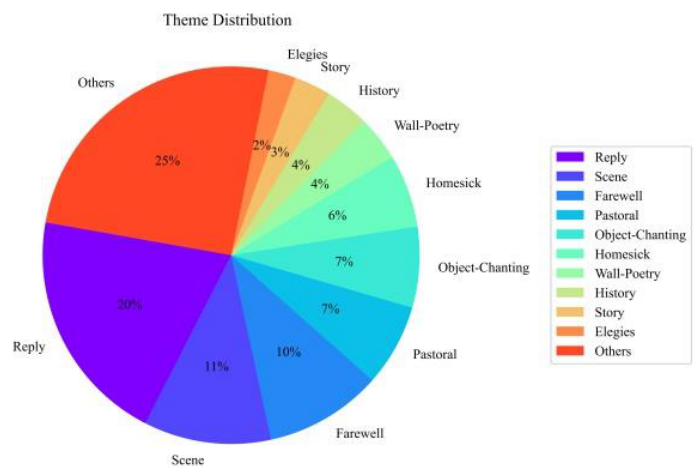
Figure 2. Theme distribution of 20 poets in the Tang Dynasty.